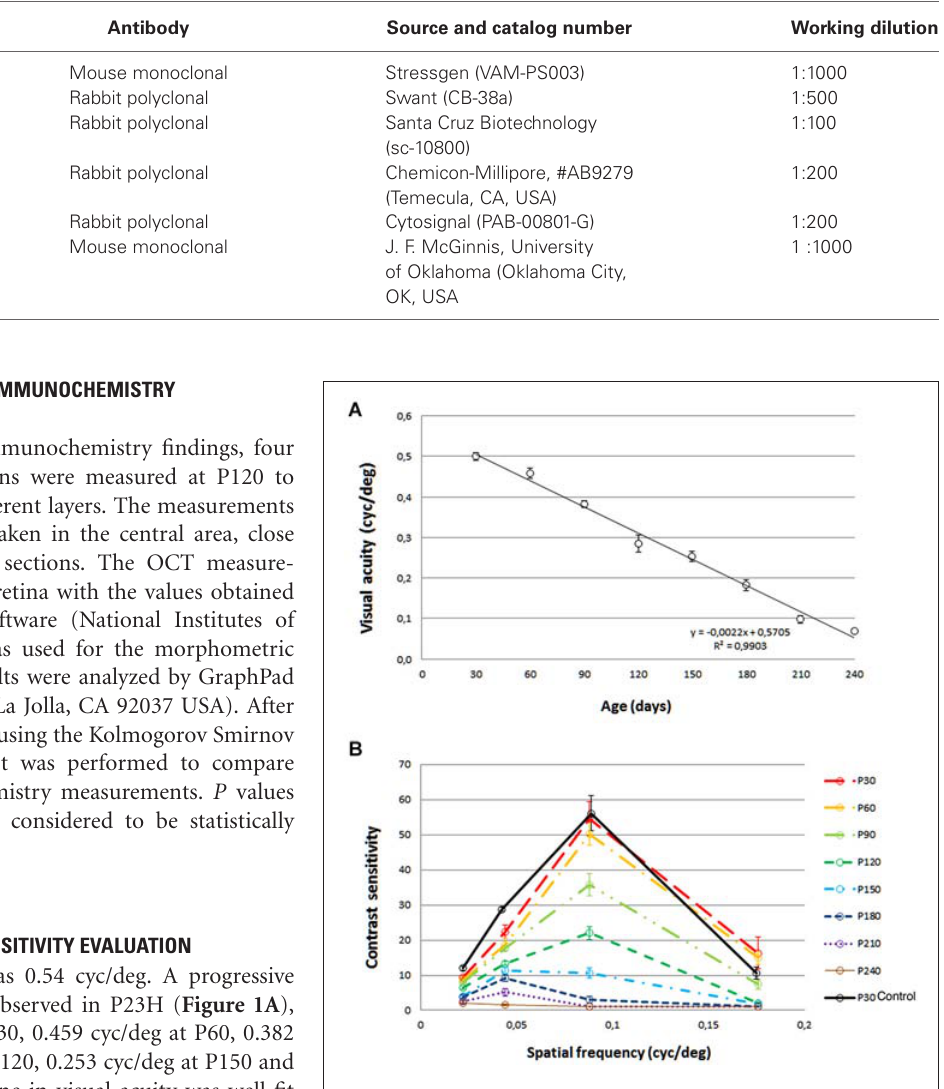
FIGURE 1 | Visual acuity (A) and contrast sensitivity (B) from rats aged 30 days to 240 days . Values are compared to those of normal LExSD rats. Each point represents the mean value of 8 rats. Euthanization for histology limited the data at 150, 180, 210 and 240 days to 7 rats. Vertical bars represent the SEM. (A) Linear fit: Visual acuity = − 0.0022 × age + 0.5705, R 2 = 0.9903.